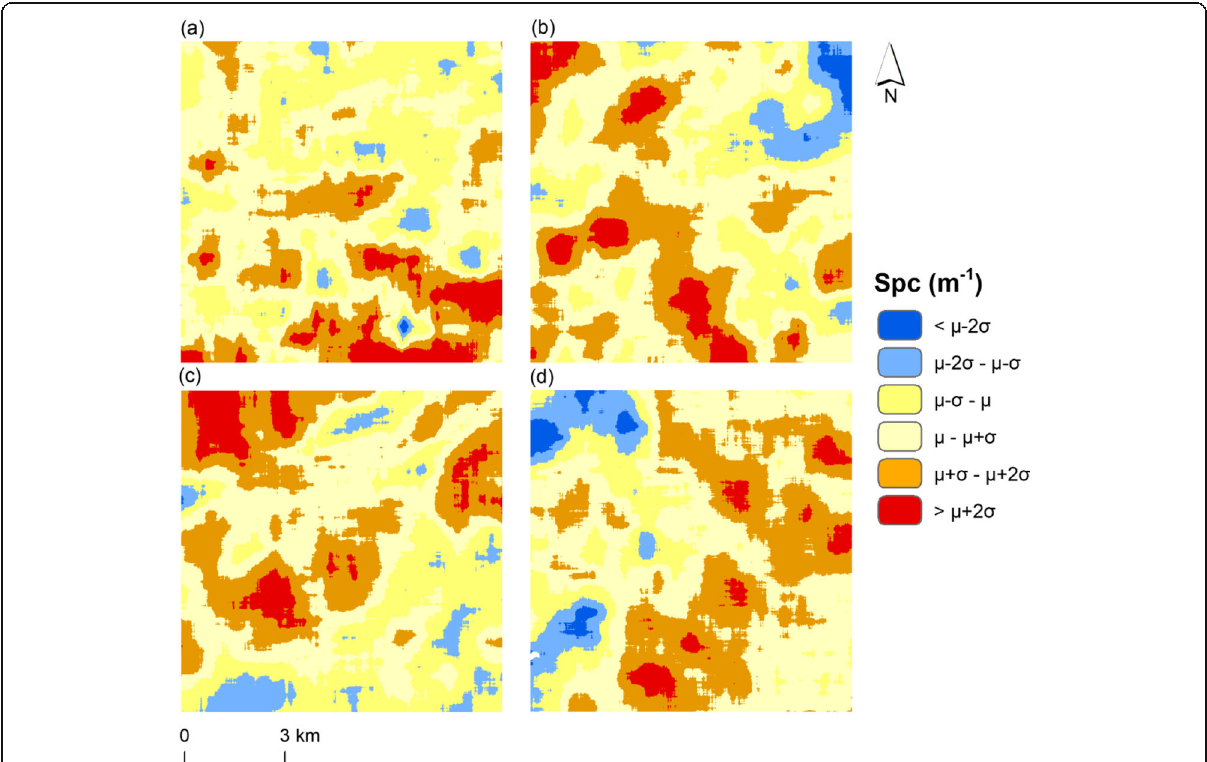
Fig. 7 Spc maps for the four study areas: a floodplain, b plain to hilly, c hilly, d mountain. Spc is colour-coded according to 1 to 2 times intervals of standard deviation σ from the mean